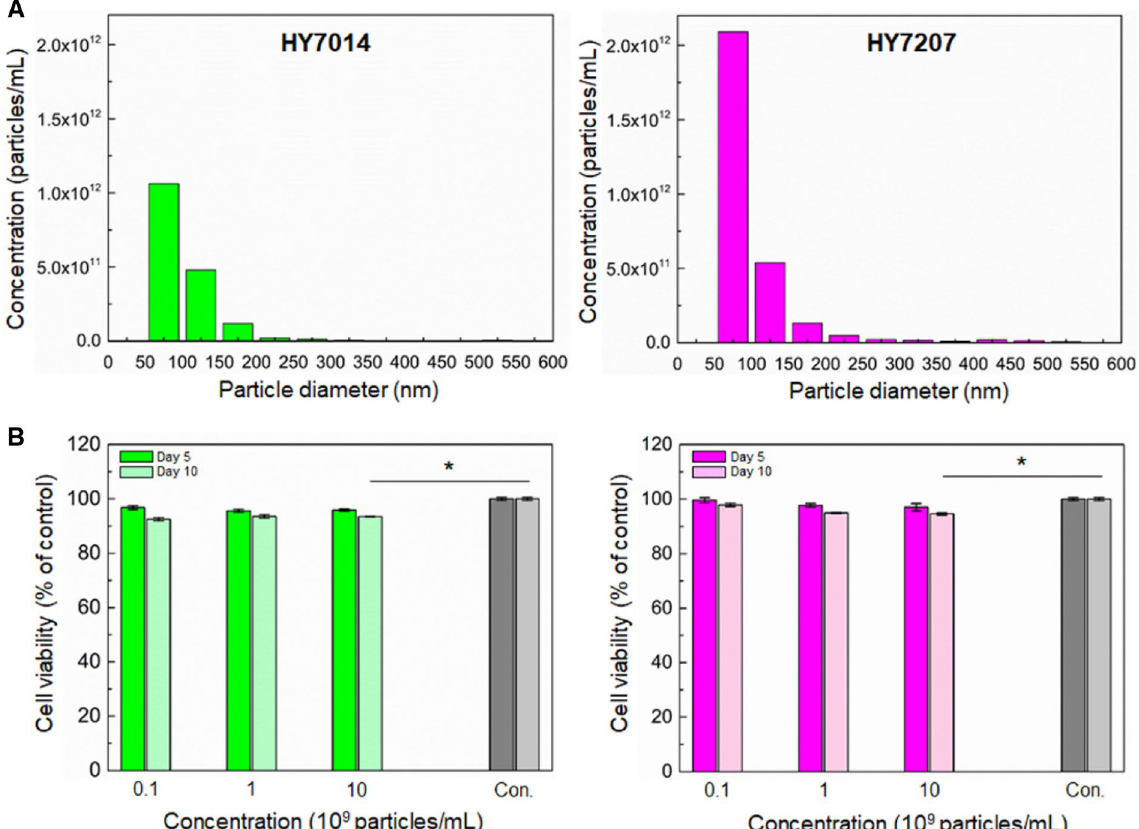
Fig. 6 Characterization of microbiota‑derived extracellular vesicles. A Size distribution analysis of exosome‑enriched EV samples analyzed by TRPS system. B Percentage of viable cells, measured as LDH release, after treatment with various concentrations of EVs (0.1 mL), Data are represented as the mean SEM of four independent experiments. * p < 0.05 for control vs. each group ±